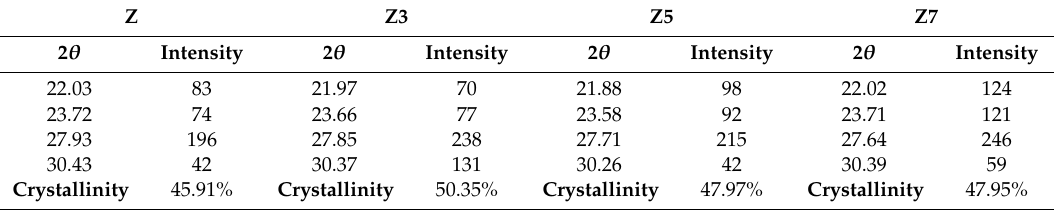
Table 4. 2 θ (degree) peak intensity comparison of Z, Z3, Z5, and Z7.